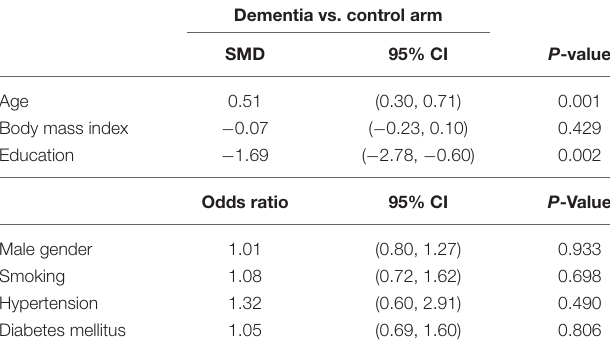
TABLE 2 | Pooled weighted characteristics.